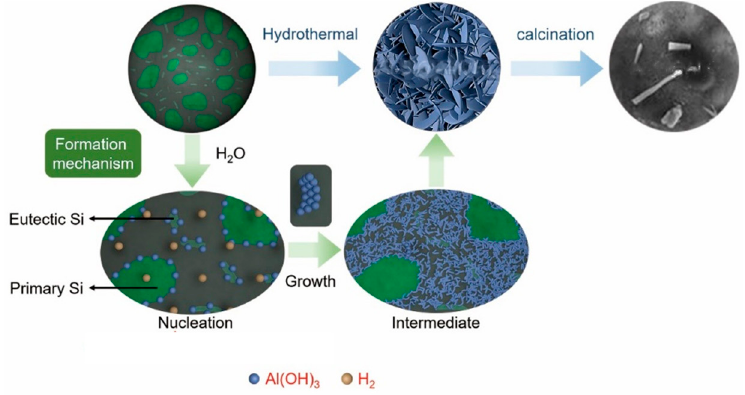
Figure 1. Preparation fl ow chart of Al–20Si@Al 2 O 3 .